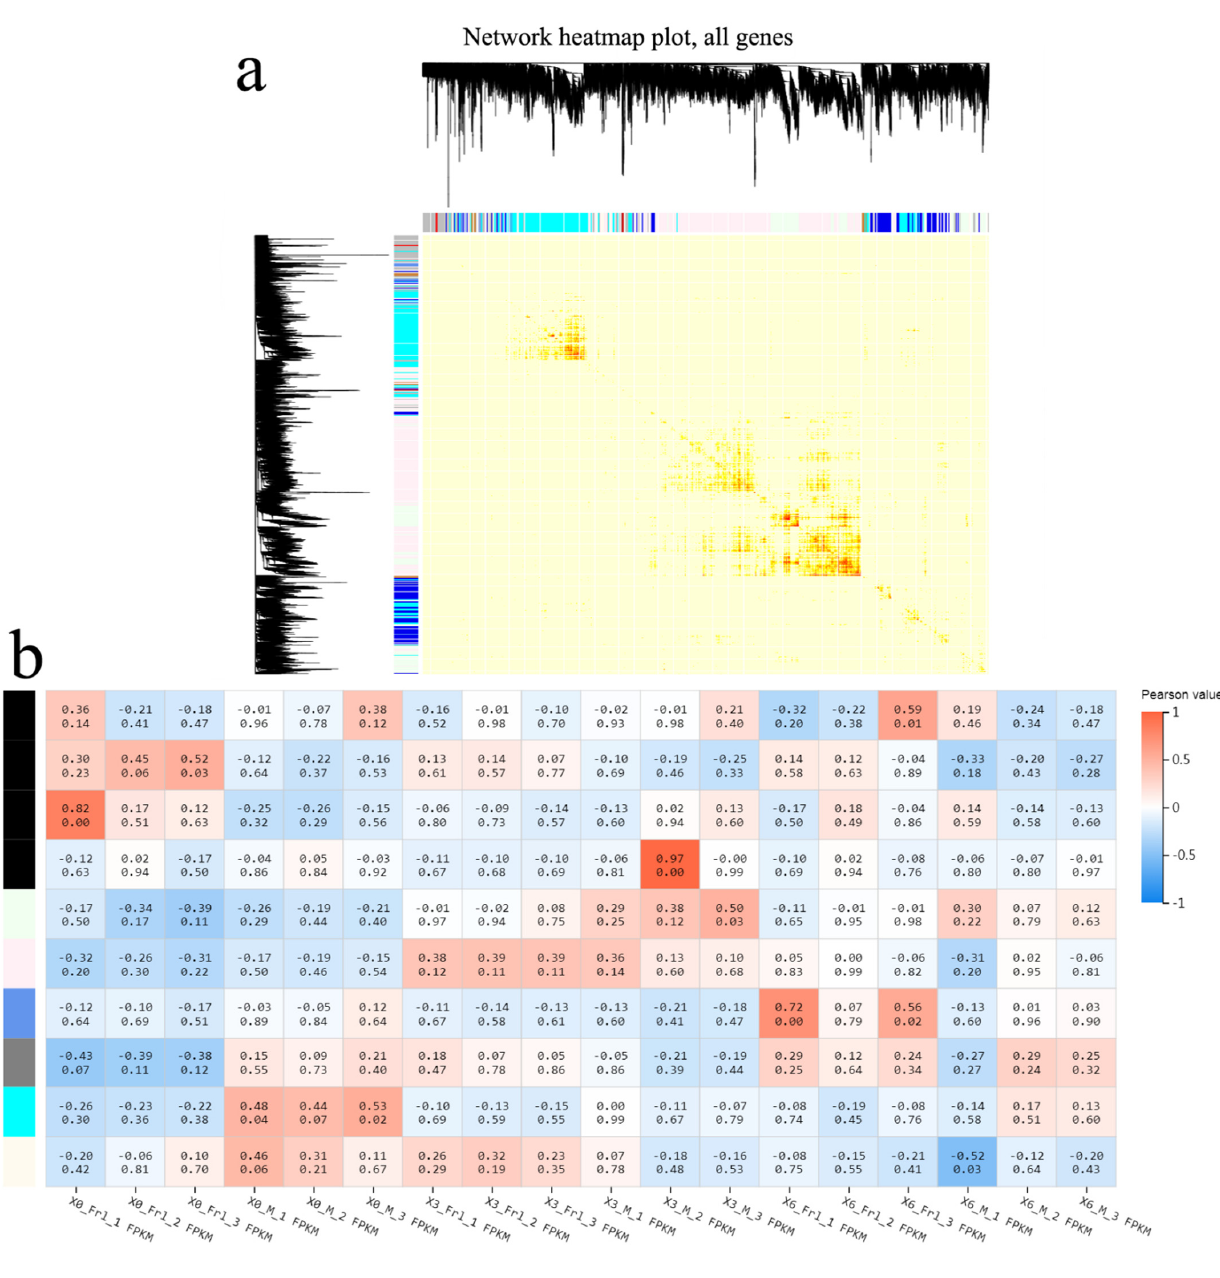
Figure 5. Gene co-expression network analyses via WGCNA. ( a ) Gene tree coloured per the relation- ship between genetic expression levels. Different colours denote different genetic modules and reflect different coefficients between genes. ( b ) Module–specimen relationship. The abscissa denotes the specimens, and the ordinate denotes the modules. The numbers in each cell denote the coefficients of association ( top ) and P results ( bottom ). The alteration from blue (low) to orange (high) denotes the DEG ranges.